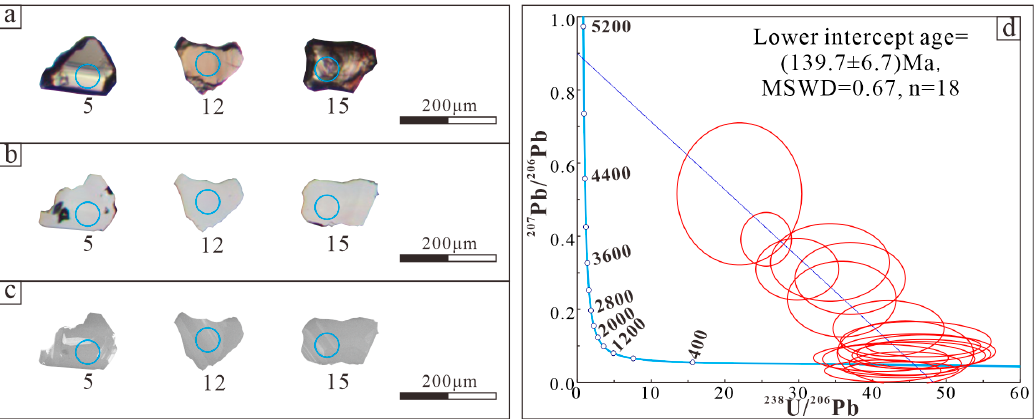
Figure 3. Cassiterite U–Pb dating results of the Dongcao muscovite granite: ( a ). transmitted image; ( b ). re fl ected image; ( c ). CL image; ( d ). cassiterite U ‒ Pb Tera–Wasserburg Concordia diagram.